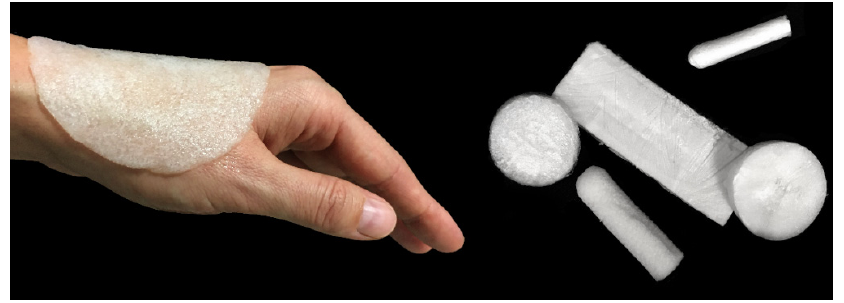
Figure 4. Foam-like agarose/curdlan dressing materials with different shapes and sizes produced according to Polish patent no. PL 236367.